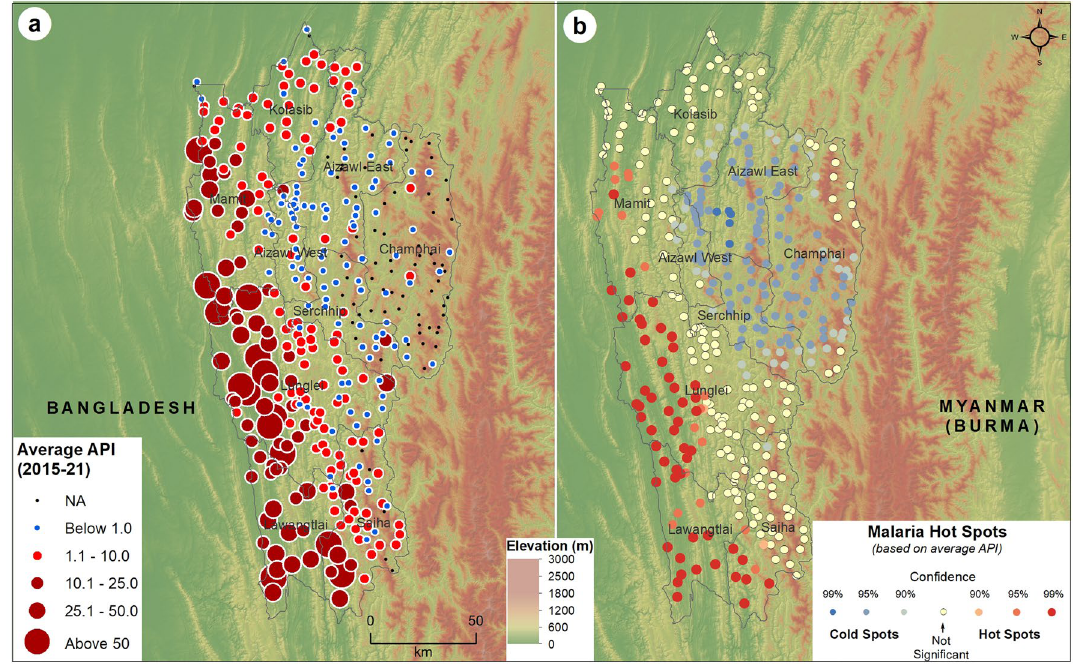
Figure 4. Distribution of ( a ) average Annual Parasite Index (2015–2021) and ( b ) spatial clusters of malaria cases in Mizoram based on average Annual Parasite Index. The large size circle with dark red color ( a ) shows the higher values (> 10) of API. The red and blue shaded dots represent ( b ) the hot and cold spots, respectively of malaria cases in Mizoram with different statistical significance. The yellow-colored dots are not statistically significant for forming hot or cold spots. The background shades represent the elevation above mean sea level extracted using NASA SRTM (Shuttle Radar Topography Mission) Global 30 arc second DEM data available at https:// doi. org/ 10. 5067/ MEaSU REs/ SRTM/ SRTMG L30. 002. The map layout was created using licensed version of ArcGIS 10.4 software by Esri. For more information about Esri software, please visit www. esri. the hotspots for malaria over the study period. In 2020 and 2021, the hotspots extended eastwards, with the emergence of malaria hotspots in the sub-centers of Siaha. A similar pattern was observed with the evolution of Pf hotspots in Mizoram (Supplementary Figure S11), as the majority of the total cases are Pf . Pv hotspots were primarily concentrated in the sub-centers of Aizawl and Kolasib cities from 2015 to 2017. From 2018 to 2019, a shift in the Pv hotspots towards the south and western parts of Aizawl was observed. The majority of the sub-centers surrounding the city of Siaha emerged as hotspots for Pv in 2020 (Fig. 5). Association with environmental variables. The spatial distribution of LU/LC of Mizoram and the bordering areas is shown in Fig. 6. The shrubland is the dominant LU/LC type along the Western border of Mizoram, especially in Mamit, Lunglei, and Lawngtlai. The LU/LC was dominated by dense forests towards the Eastern border. A Jhum type of cultivation is dominant in the Eastern hilly terrains, especially in the Champhai district. The spatial distribution of maximum temperature, minimum temperature, temperature range, rainfall, and relative humidity from 1981 to 2021 are shown in Fig. 7. Analysis of the annual meteorological data from 1981 to 2021 shows the western districts of Mizoram experience similar climatic conditions as the bordering districts located in the Chittagong division of Bangladesh. The terrain settings of Mizoram, along with Eastern and Western border regions, are also presented in Fig. 7. The spatial clusters of malaria are overlaid in the maps of environmental variables for a better understanding of malaria and its environmental settings (Figs. 6 and 7). The LU/LC distribution shows the malaria hotspots of Mizoram are primarily located in the shrublands that border the mixed or dense forests. Such a pattern of LU/LC is also observed in the Chittagong Hill Tract of Bangladesh, with a transition of deciduous forests to shrublands to croplands. Analysis showed a statistically significant difference in the number of malaria cases between the mean ranks of at least one pair of groups, χ 2 (2) = 19.652, p < 0.001. The pairwise comparison matrix estimated by the Kruskal–Wallis H test also shows a significant positive association ( p < 0.0001) of forest categories (dense, mixed, and shrub forests) and malaria cases (Table 1 and Supplementary Table 12). The spatial overlay of malaria clusters and climatic parameters shows the maximum temperature experienced in the malaria hotspot regions of Mizoram is 35–36 °C (Figure 7a), the minimum temperature is 13–15 °C (Fig. 7b), and the average diurnal range is 15–17 °C (Fig. 7c). Malaria hotspots were primarily clustered in Lawngtlai, Lunglei, Mamit, and Siaha districts which are with relatively higher temperatures (maximum is above 35 °C and the minimum is 13–14 °C), whereas coldspots were observed in the elevated districts (Champhai, Aizawl, and Serchhip) with relatively lower temperatures (maximum is less than 34 °C and the minimum is less